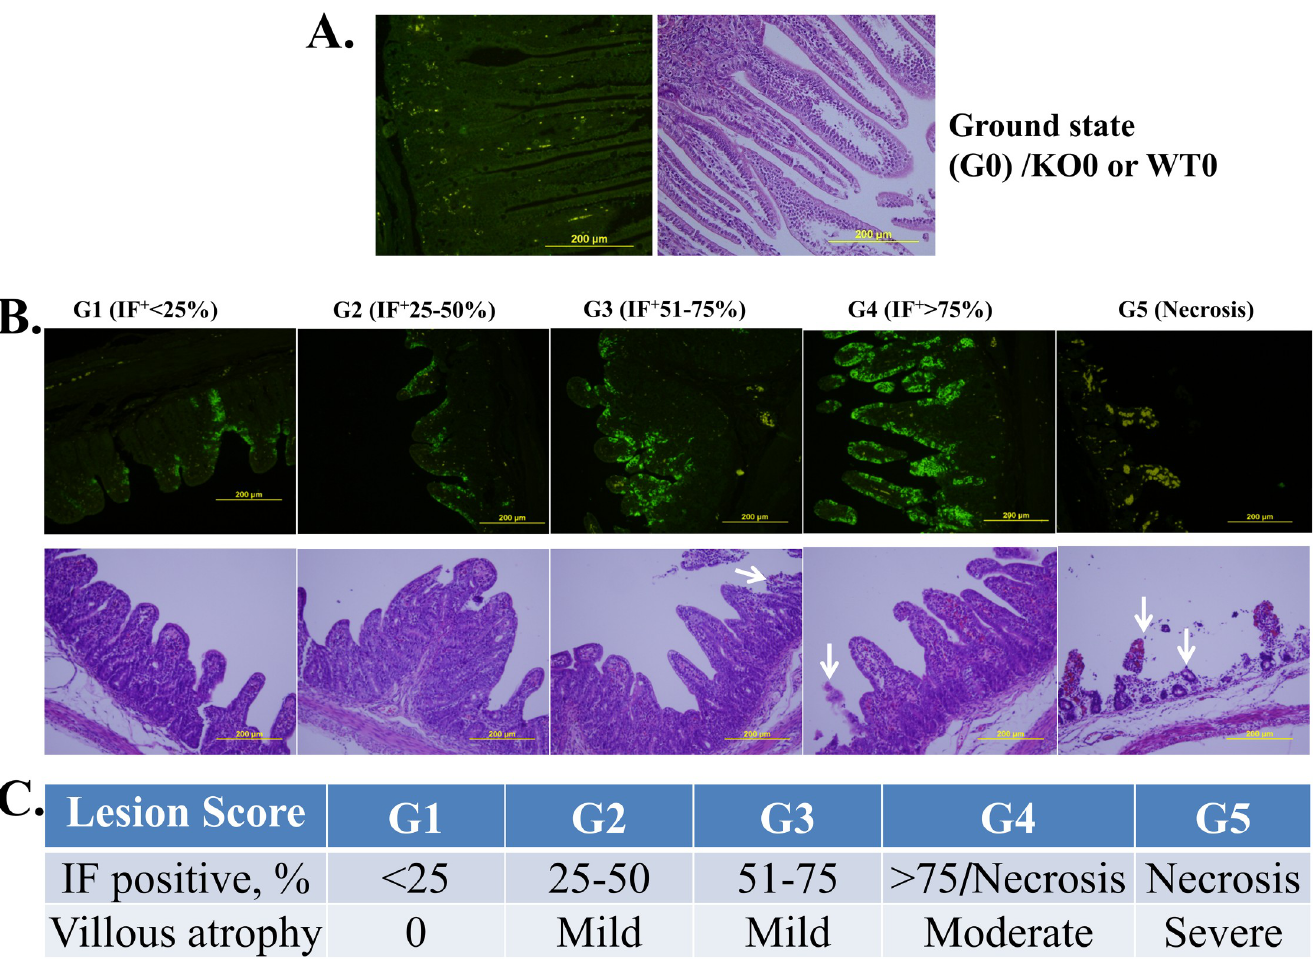
Fig 2. Evaluation criteria based on immunofluorescence staining and histopathological lesions (I/H score) of piglets’ intestine samples after PEDV challenge. A. KO0 or WT0 controls for the ground state, G0. B. IF is scored as G1 to G4 based on the relative intensity of staining, whereas G5 is based on villar atrophy or defoliation observed by H/E inspection. The corresponding scores are shown in C. The arrows indicate necrotic villi; the yellow bars represent 200 μ m.